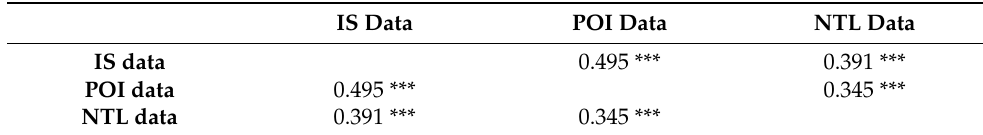
Table 3. Partial correlation coefficients between all variables in the township scale (***—at the 1% level).